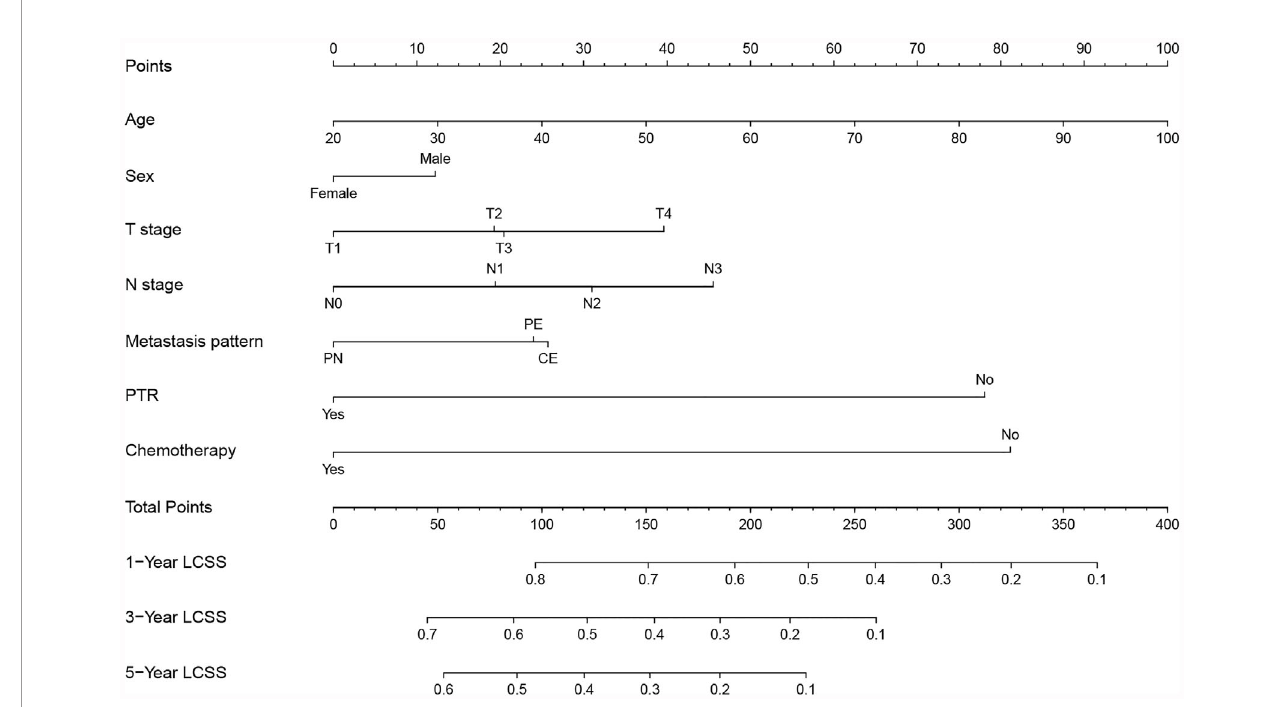
FIGURE 1 | Prognostic nomogram predicting probability of 1-, 3- and 5-year lung cancer-speci fi c survival (LCSS) in NSCLC patients with ipsilateral pleural dissemination. PN, pleural nodules; PE, pleural effusion; CE, pericardial effusion; PTR, primary tumor